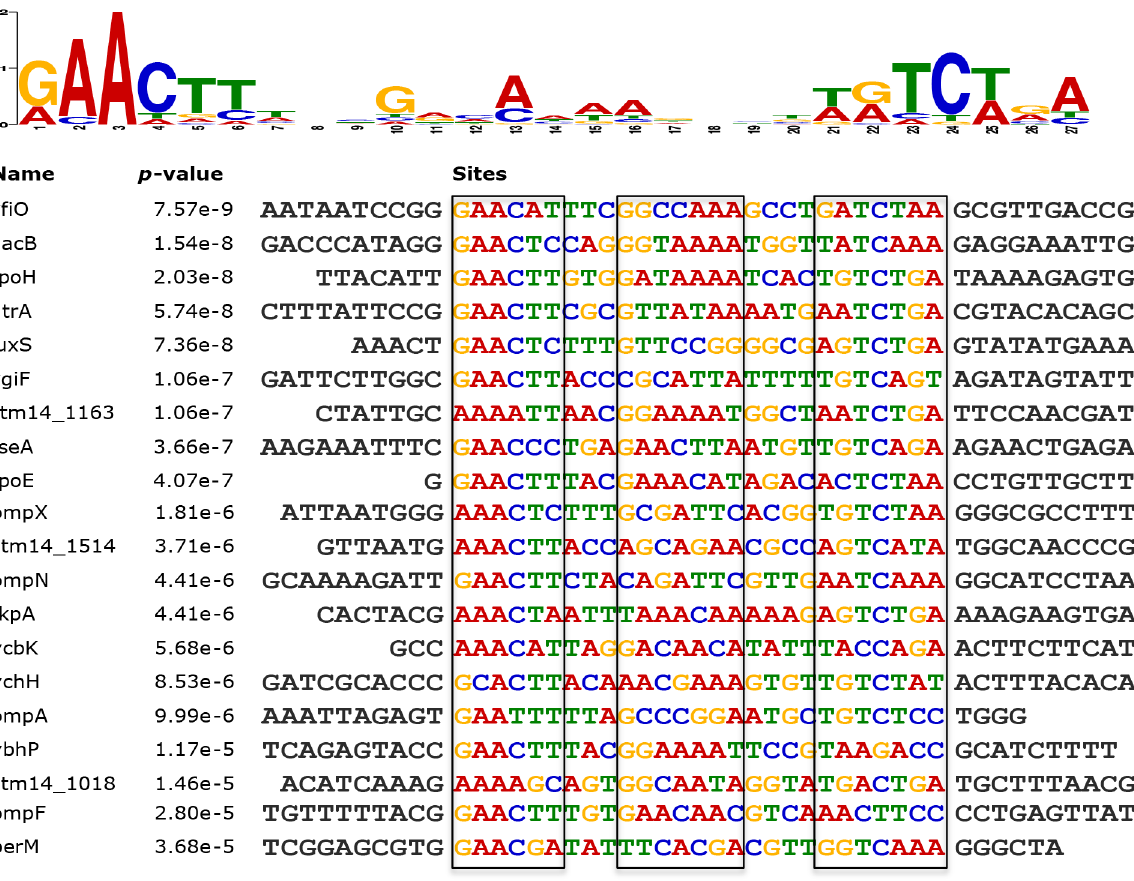
Fig 3. Consensus sequence of STM σ E during in vivo infection. The top represents the sequence logos reflecting the prevalence of each symbol by height. Beneath is the nucleotide alignment of the ChIP-seq pulldowns that contain the consensus sequence